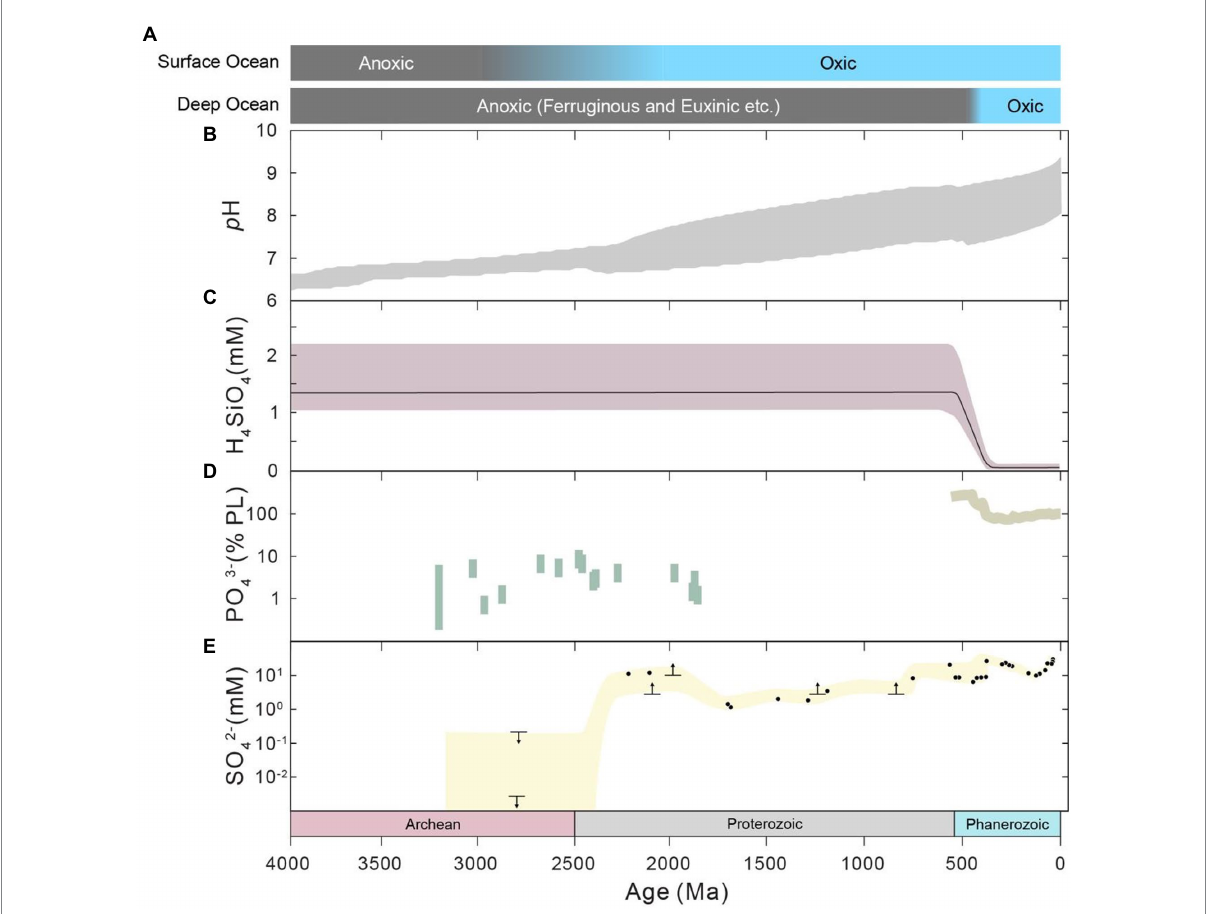
FIGURE 3 Evolution of seawater conditions and composition through Earth history. (A) Redox state, after Sperling et al. (2015). (B) Marine pH, which is the results within the 95% confidence interval from Halevy and Bachan (2017). (C) Marine silica concentration, from Isson and Planavsky (2018). (D) Marine dissolved phosphate concentration. Results of the Precambrian (left) are from Bjerrum and Canfield (2002), Konhauser et al. (2007) and Jones et al. (2015), which were constrained by the Fe/P ratios of iron-rich sediments. The results of the Phanerozoic (right) are from the model results of Lenton et al. (2018). (E) Marine sulfate concentration, taken from Habicht et al. (2002), Planavsky et al. (2012) and references therein, Crowe et al. (2014) and Blättler et al.